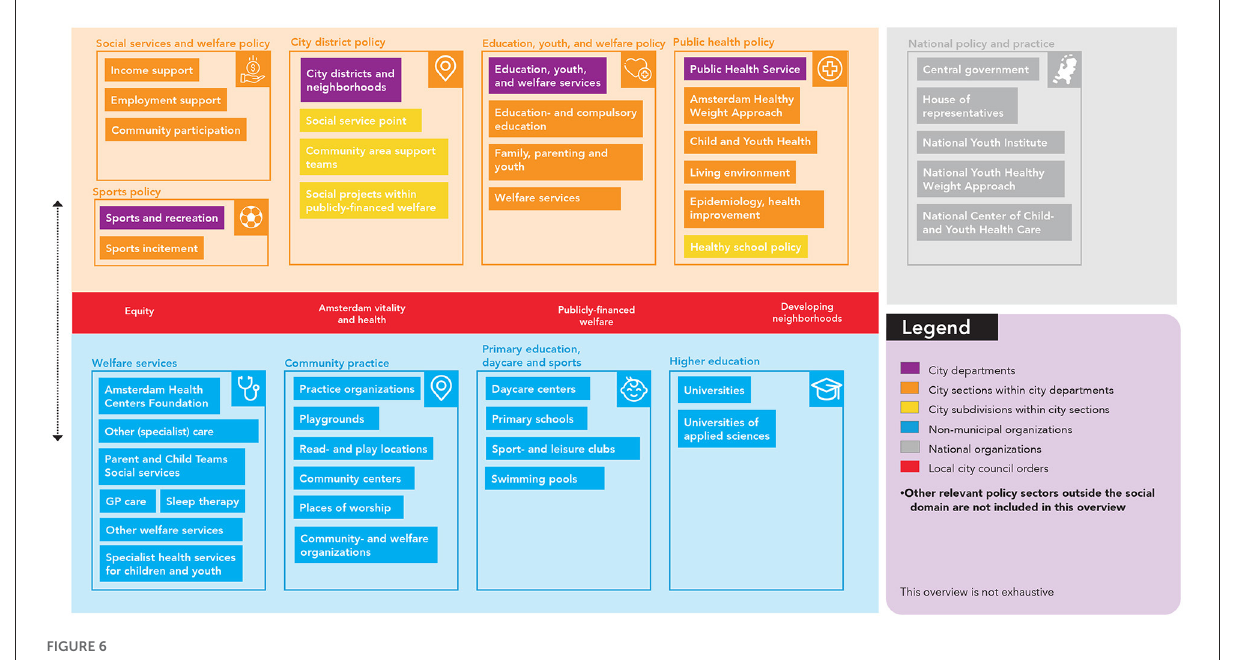
FIGURE6 Overview of the local organizational